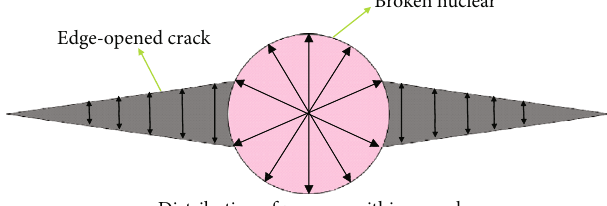
Figure 5: Schematic diagram of pressure inside a